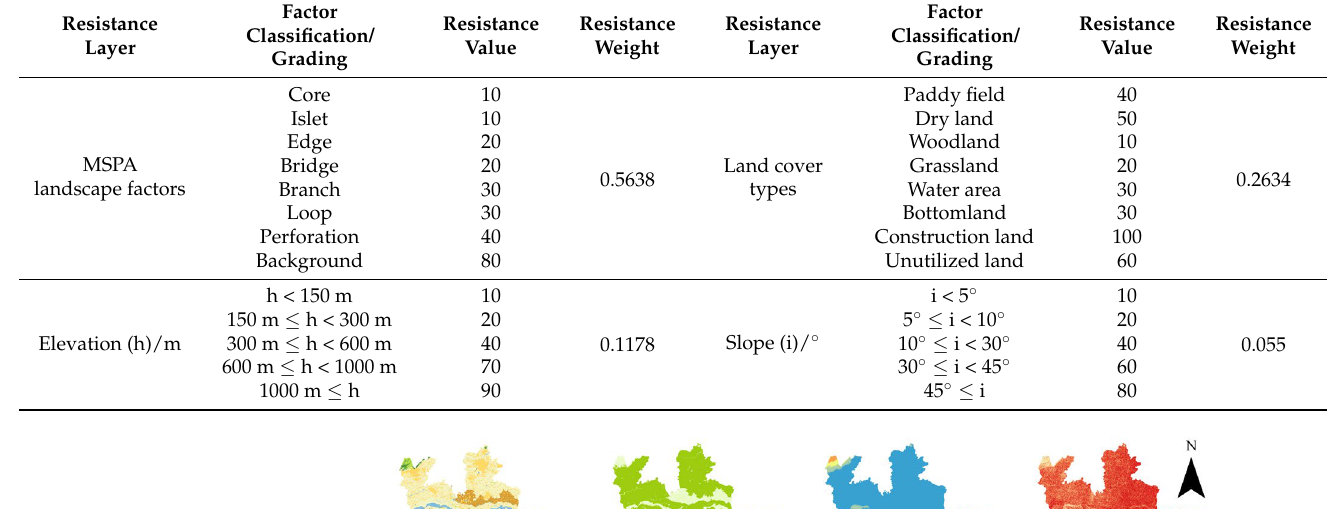
Table 4. Graded coefficients of ecological resistance.